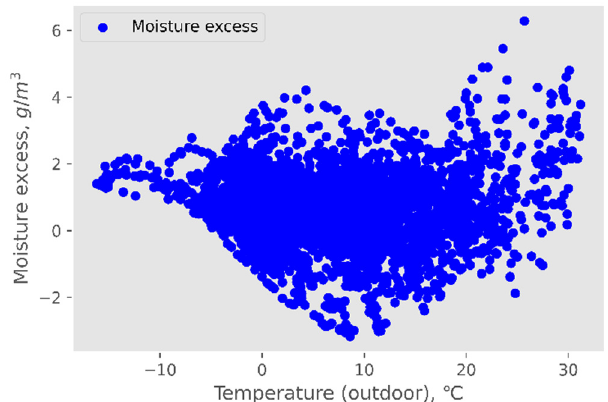
Figure 9. Moisture excess in Krimulda church on the balcony.